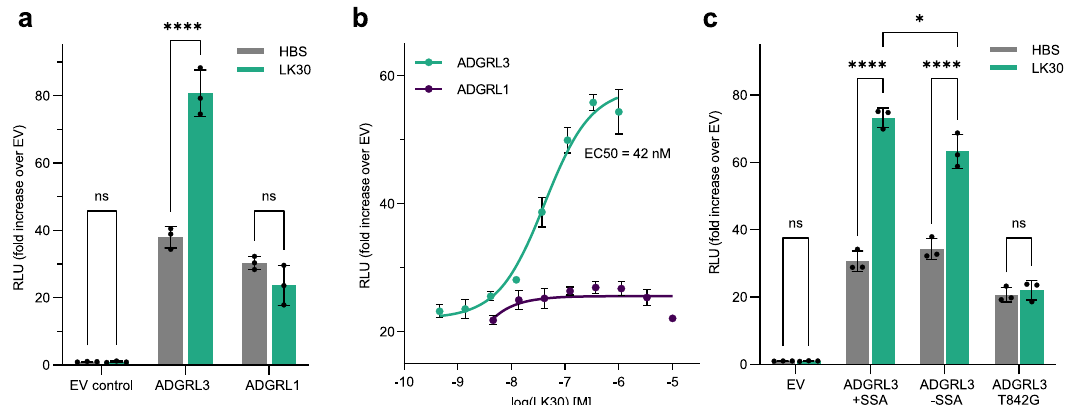
Fig. 2 | LK30 is anADGRL3-speci fi c activator. a SRE-luciferase assayforsignaling ofADGRL3andADGRL1intheabsenceorpresenceof1 µ Mpuri fi edLK30presented asfold increase over empty vector (EV).RLU, relative luminescence units. Data are presented as mean±SD of three repeats (n=3) for a representative of three inde- pendent experiments. ns p >0.9999; **** p <0.0001; ns p =0.6411 vs. HBS buffer treatment; two-way ANOVA. b Titration of LK30 on SRE-luciferase activity of ADGRL3 (cyan) and ADGRL1 (purple). The EC50 value of LK30 on ADGRL3 was